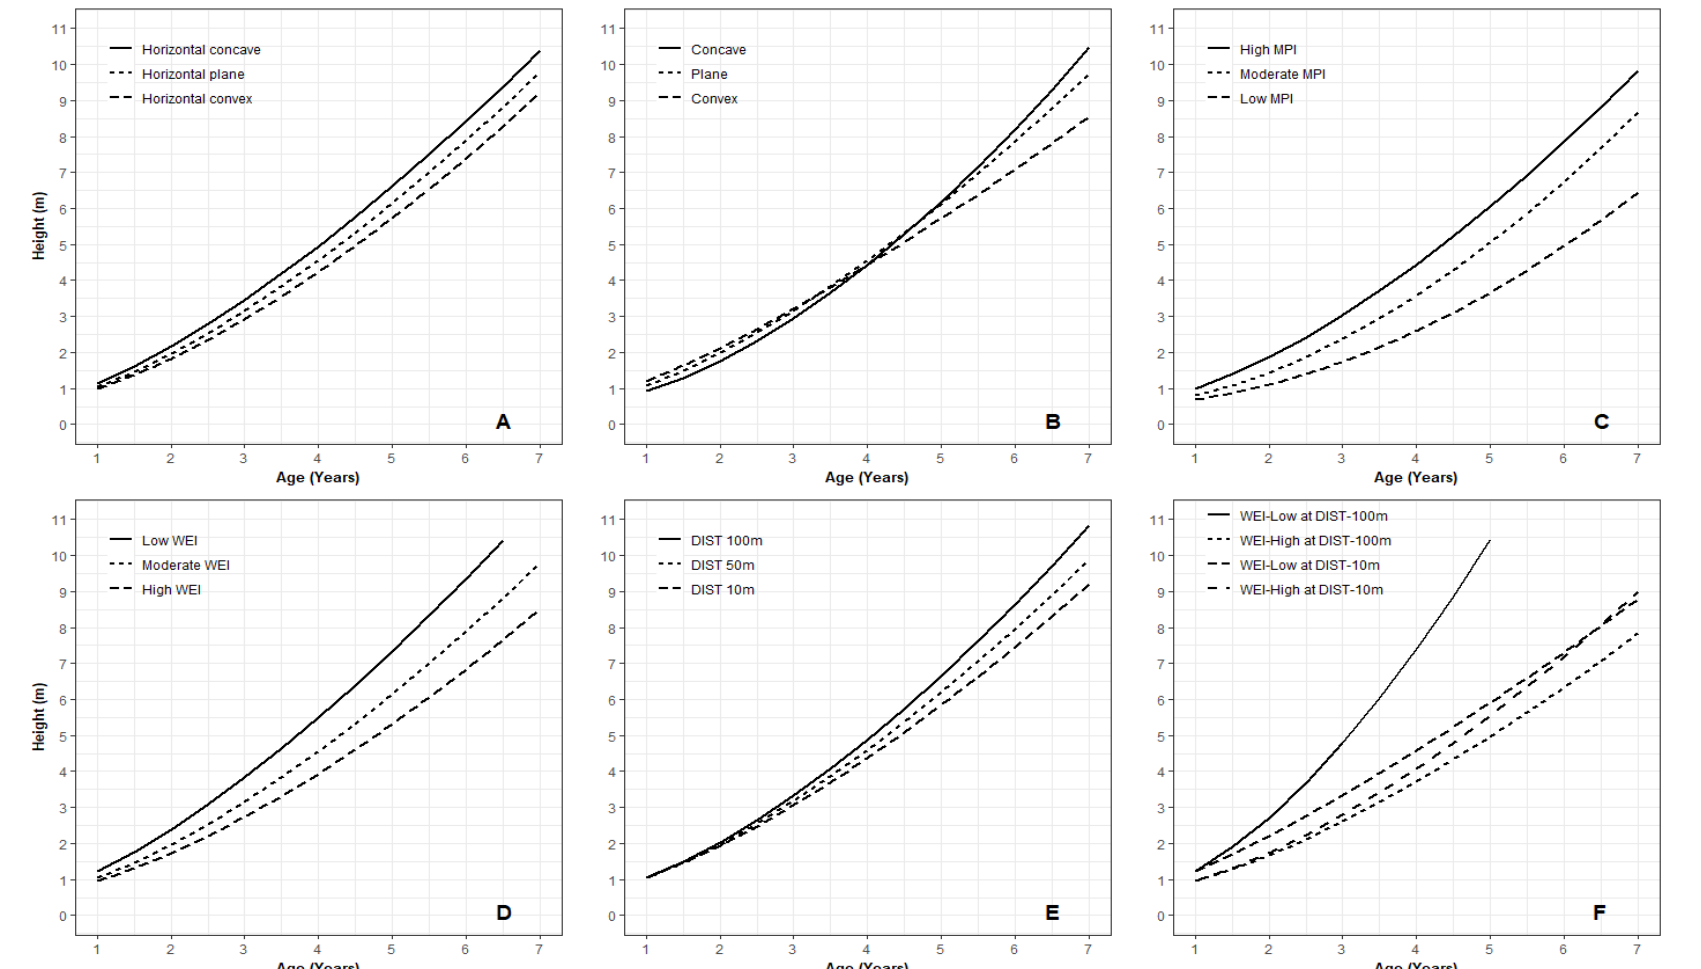
Figure 4. Topographic effects on E. bosistoana height growth at site B. ( A ) Effect of plan curvature, ( B ) effect of topographic position index, ( C ) effect of morphometric protection index, ( D ) effect of wind exposure index, ( E) effect of distance from the top ridge effect and ( F ) effect of the interaction between WEI and DIST.